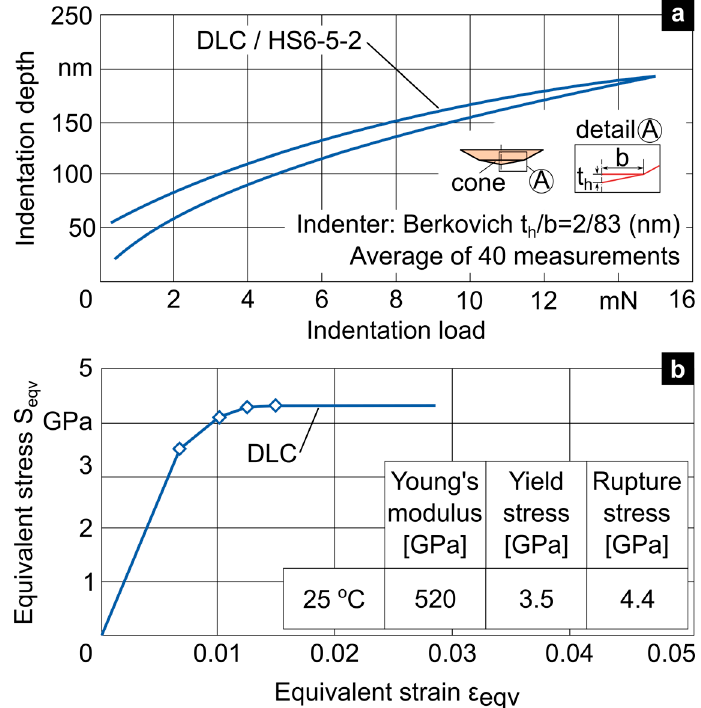
Figure 7. ( a ) Nanoindentation results on the applied diamond-like carbon (DLC) coating at ambient temperature; ( b ) stress–strain curve of the DLC coating, attained via an FEM supported evaluation of the nanoindentation results.